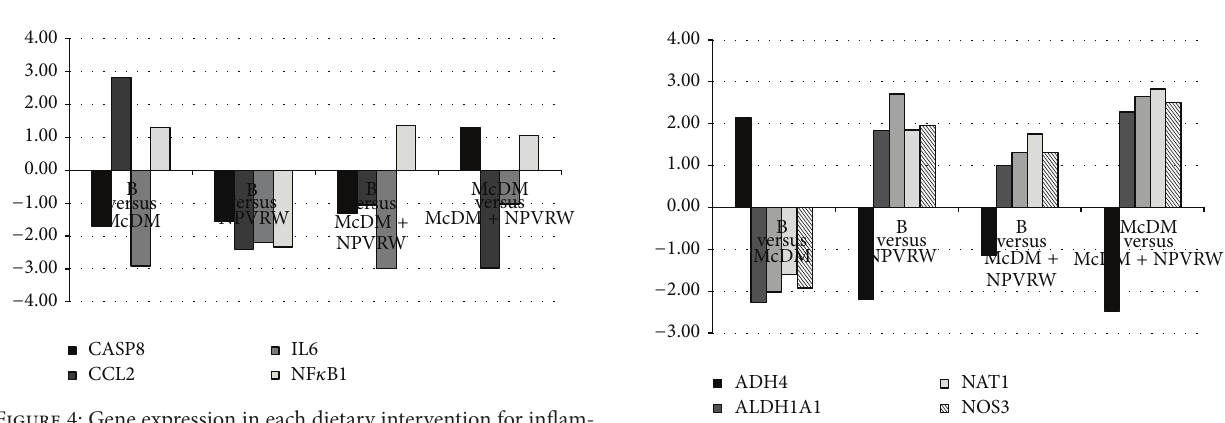
Figure 4: Gene expression in each dietary intervention for inflam- masome pathway. Different levels of up- and downregulation of genes analyzed between McDonald’s meal andMcDonald’s meal with not pruned vineyard red wine. The significant values are expressed as 𝑃 ≤ 0.05 for a level of fold change > ± 2.00. Inflamma- some genes: CASP8 , Caspase 1 apoptosis related cysteine peptidase (NM 1228); CCL2 , chemokine (C-C motif) Ligand 2 (NM 2982); IL6 , Interleukin 6 (NM 600); NFKB1 , Nuclear Factor of Kappa Light Polypeptides Gene Enhancer in B-Cells 1 (NM 3998).